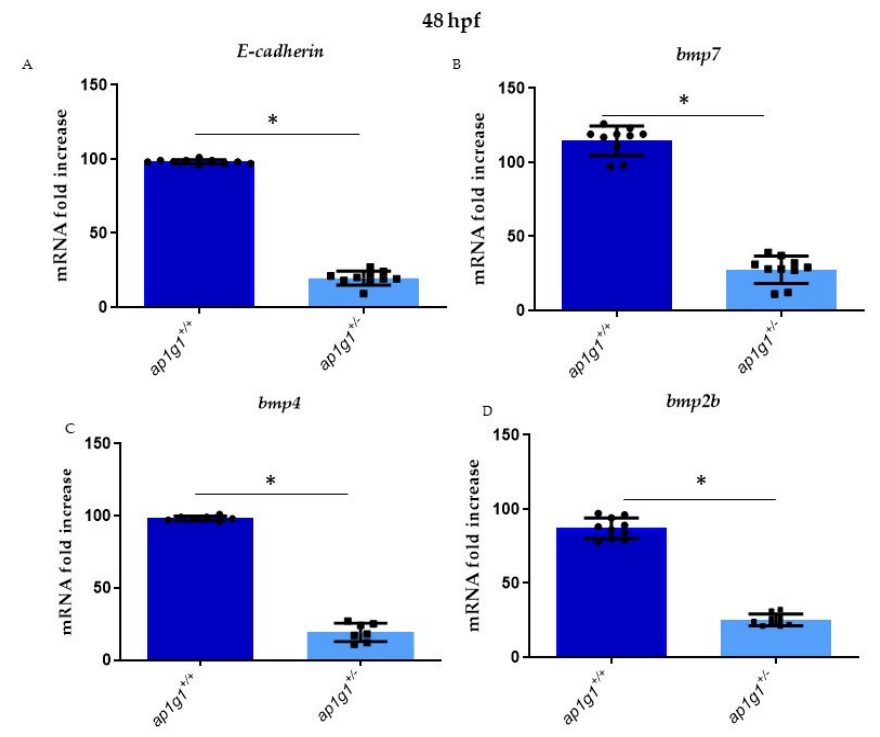
Figure 7. ( A – D ) Alterations of E-cadherin expression and different BMP factors in heterozygous and wild-type embryos, respectively: E-cadherin, bmp7, bmp4 and bmp2b. qPCR experiments were per- formed at 48 hpf in triplicate on cDNA samples derived from n = 30 whole embryos per condition to measure the mRNA level of E-cadherin and BMPs factor in ap1g1 +/+ and ap1g1 +/ − . Gene expression was normalized using rpl13a as a reference gene and expressed as the mRNA fold increased. Data are representative of three replicates and are shown as the mean ± standard deviation; * p < 0.01 Stu- dent’s t -test, Statistical analysis was performed with GraphPad Version 8.3.3 GraphPad Software, Inc., Version La Jolla, CA,